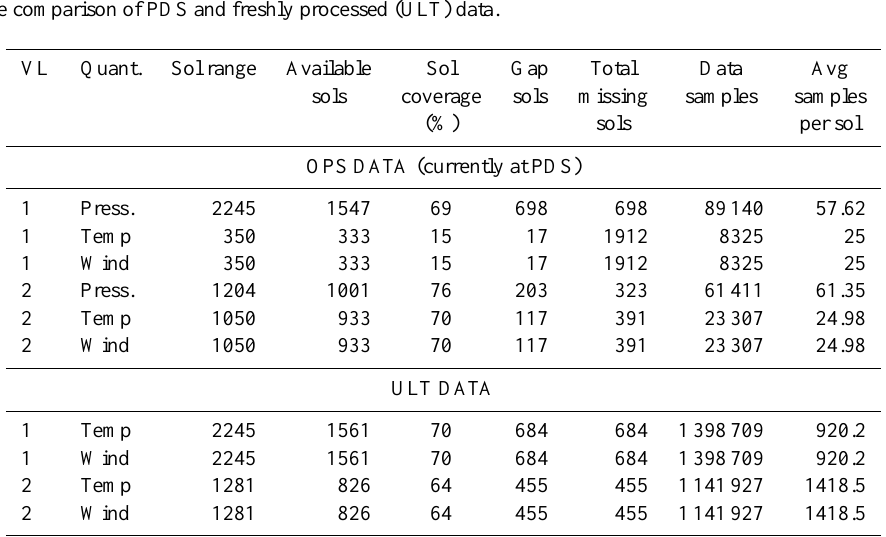
Table 6. Quantitative comparison of PDS and freshly processed (ULT) data. VL